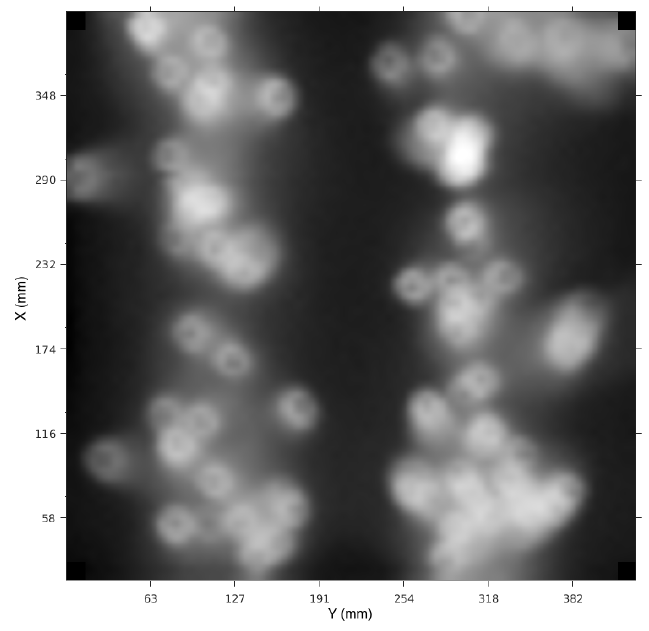
Figure 7. Wheat stubble mock-up grayscale image